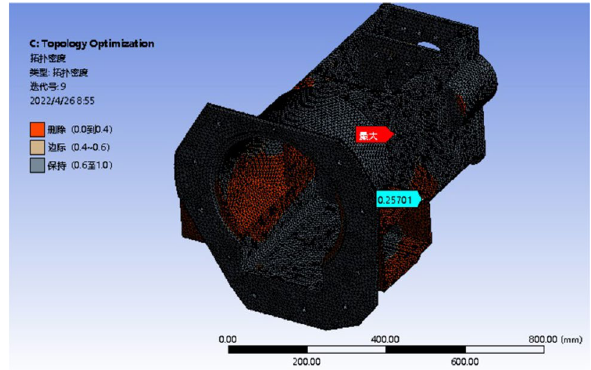
Figure 12. Optimization results with 20% mass reduction.